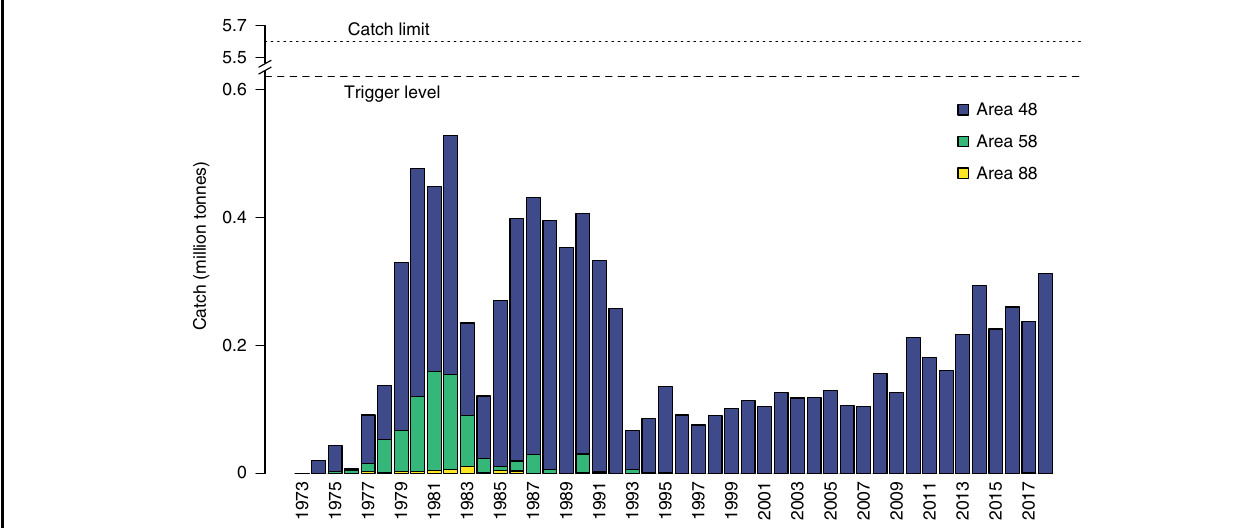
Fig. Box 2 Fishery catch (million tonnes) of Euphausia superba in the Southern Ocean from 1973 to 2018, from three CCAMLR areas − 48, 58 and 88. Management trigger level (0.62 million tonnes) and catch limit (5.6 million tonnes) also shown. Data from CCAMLR